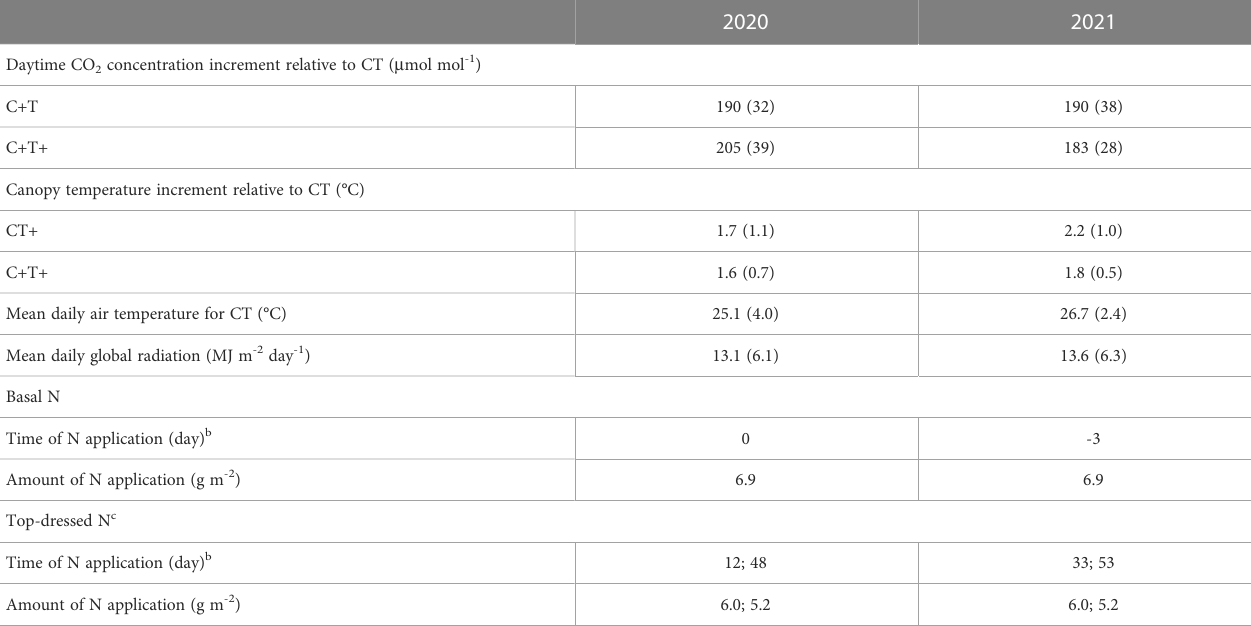
TABLE 1 Summary of environment conditions in T-FACE experiments of 2020 and 2021 a